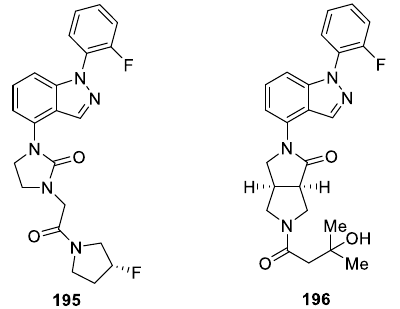
Figure 68. Chemical structures of 4-substituted-1 H -indazole derivatives 195 and 196 .